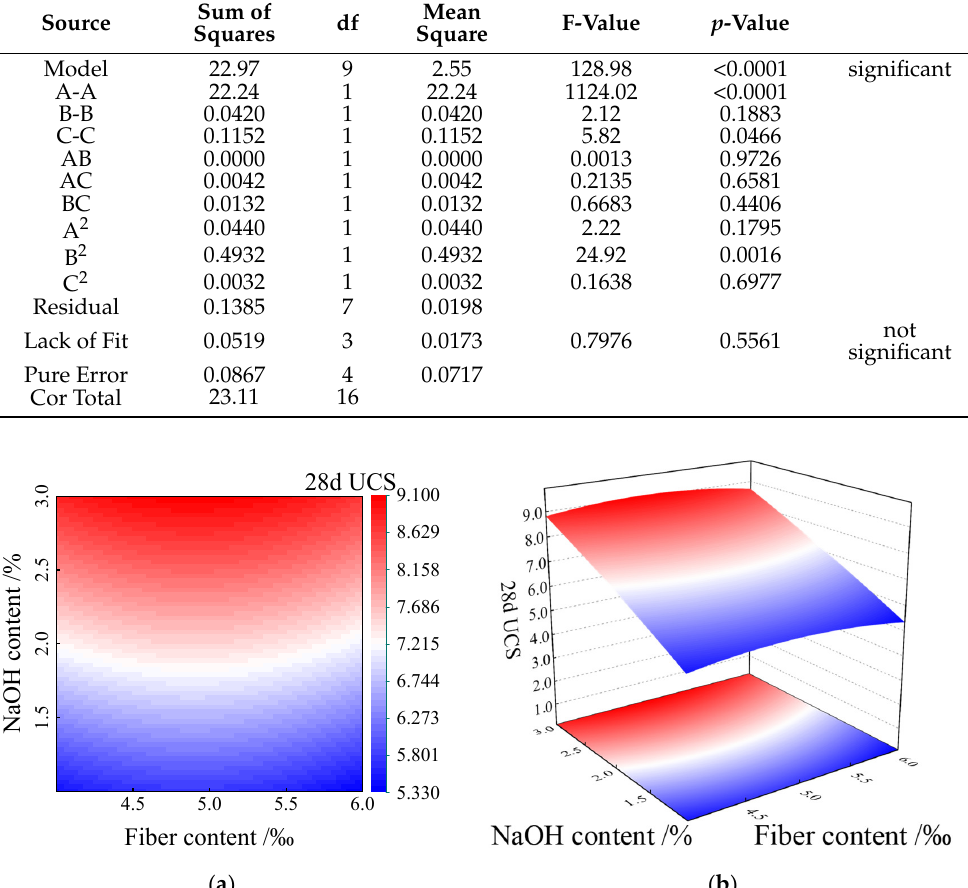
Figure 9. Interaction diagram of factors A and B on 28 d UCS. ( a ) Contour map of 28 d UCS of factors A and B. ( b ) Response surface diagram of factors A and B to 28 d UCS.